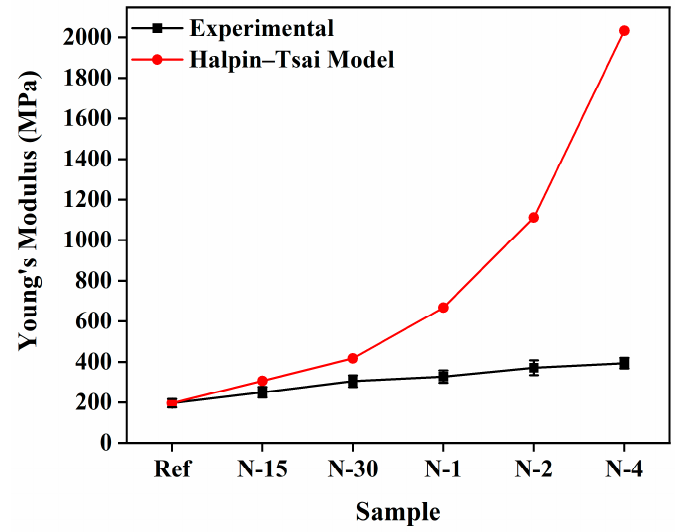
Figure 3. Comparison between the experimental E c and theoretical E c employing the Halpin–Tsai model.